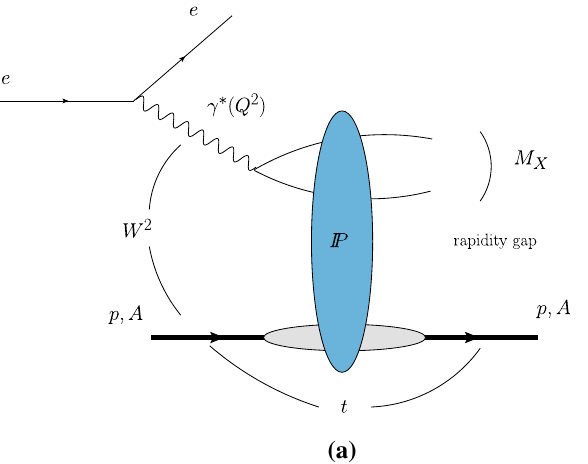
the proton or nucleus. The contributions of q ¯ q and q ¯ qg parton Fock states are presented in the left and right panels,